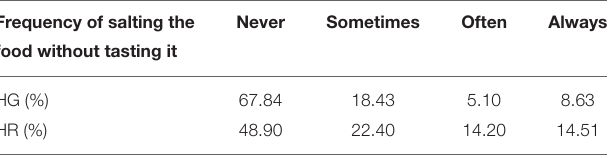
TABLE 4 | Frequency of salting food in the Hungarian general and Roma populations.